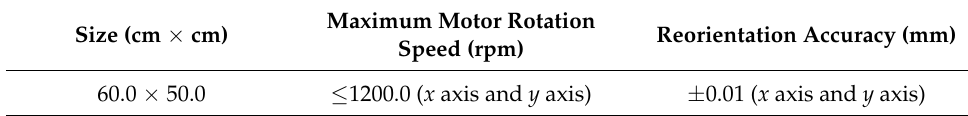
Table 4. The basic parameters of Cartesian robot in our experimental system.